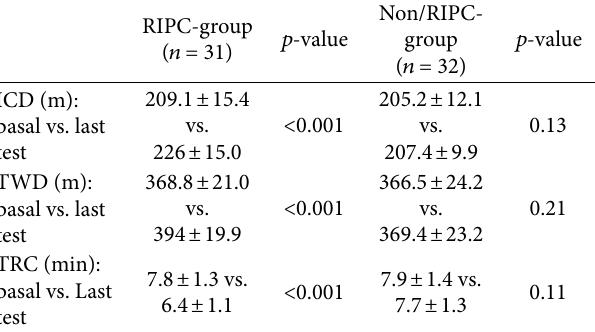
Table 2: Treadmill test parameters within